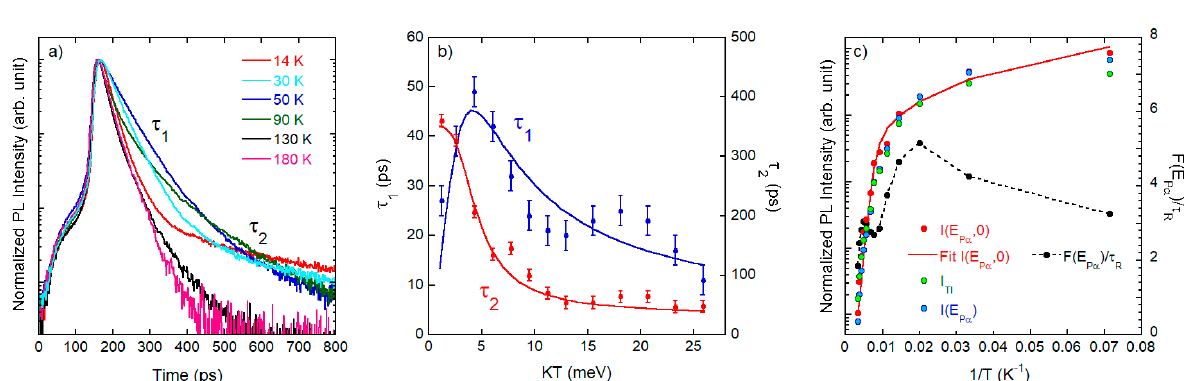
Figure 6. ( a ) PL time decay of P α at different temperatures over an extended time range. ( b ) Temperature dependence of τ 1 and τ 2 along with fits (solid lines). All data refers to sample A. ( c ) Arrhenius plots extracted from the PL intensity vs. T along with the fit (solid line); T dependence of the PL time evolution factor F(E P α )/ τ R in linear scale. The dashed line is a guide for the eyes.